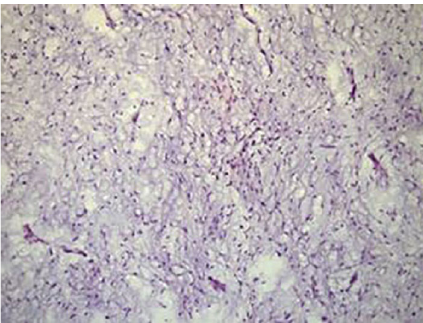
Figure 3: Spindle-shaped cells with long fi ne cytoplasmic processes, within an abundant, myxoid ground substance, containing small capillaries and fragments of bone trabecula (hematoxylin and eosin, original magni fi cation 200x).